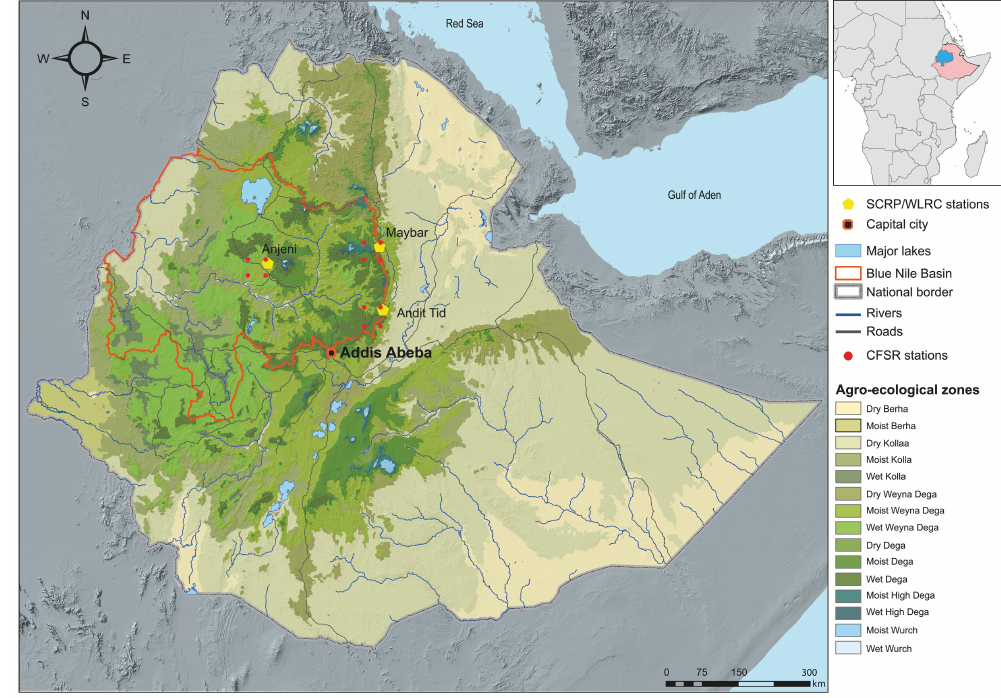
Figure 1. Map overview of Blue Nile (Abbay) Basin with the WLRC research stations, agro-ecological zones according to Hurni (1998), and emplacements of CFSR